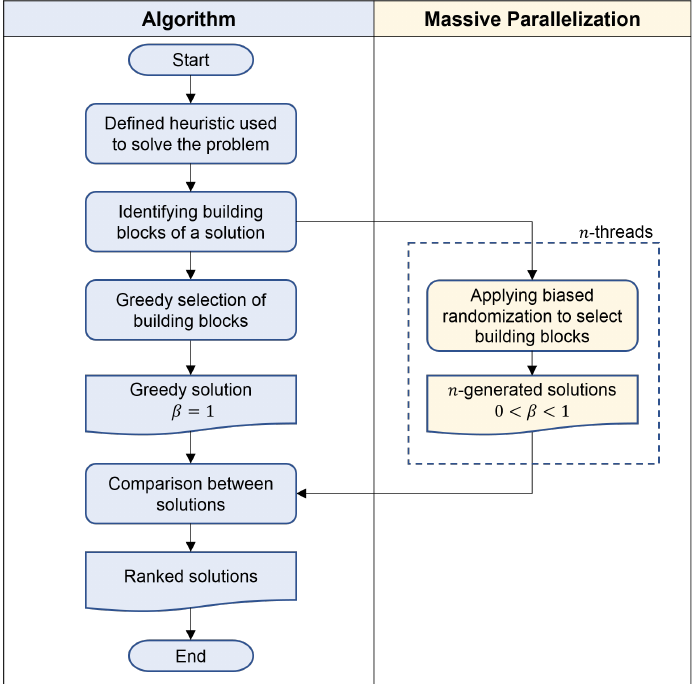
Figure 6. General schema of an agile optimization